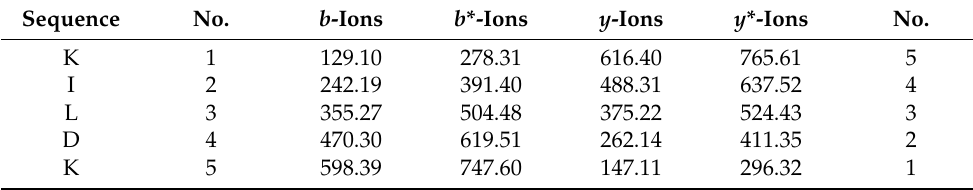
Table 6. Mass of unmodified and modified y - and b -fragment ions of the sequence KILDK.